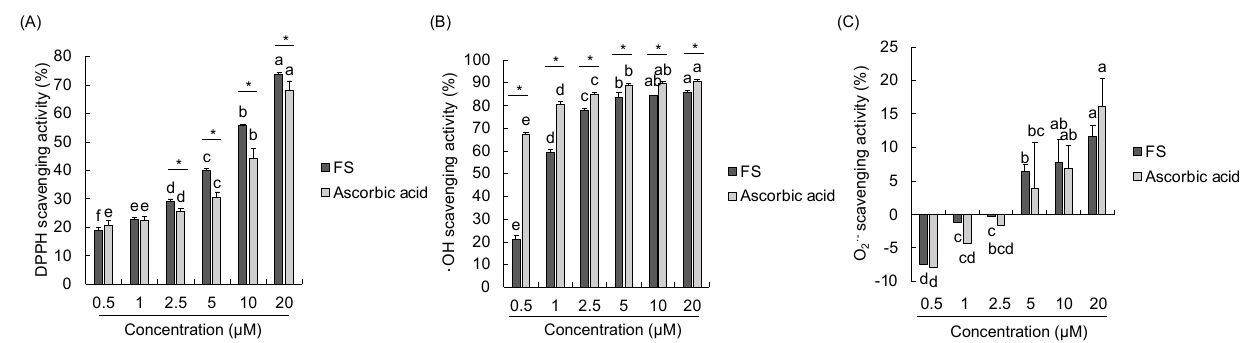
Figure 2. In vitro free radical scavenging activities of N -feruloyl serotonin. DPPH ( A ), ·OH ( B ), and O 2 · − ( C ) scavenging activities. Ascorbic acid as a standard. Values present means ± SD ( n = 4). a–f Means with different letters are significantly different ( p < 0.05) by Duncan’s multiple range test. * Represents significant difference ( p < 0.05) between FS nad ascorbic acid. FS, N -feruloyl serotonin. Table 1. In vitro free radical scavenging activities of N -feruloyl serotonin in IC 50 value (µM). DPPH ·OH O 2 · − FS 6.19 ± 0.09 1.35 ± 0.03 >100 Ascorbic acid 9.19 ± 0.69 0.03 ± 0.00 Values present means ± SD. IC 50 , half-maximal inhibitory concentration; FS, N -feruloyl serotonin.